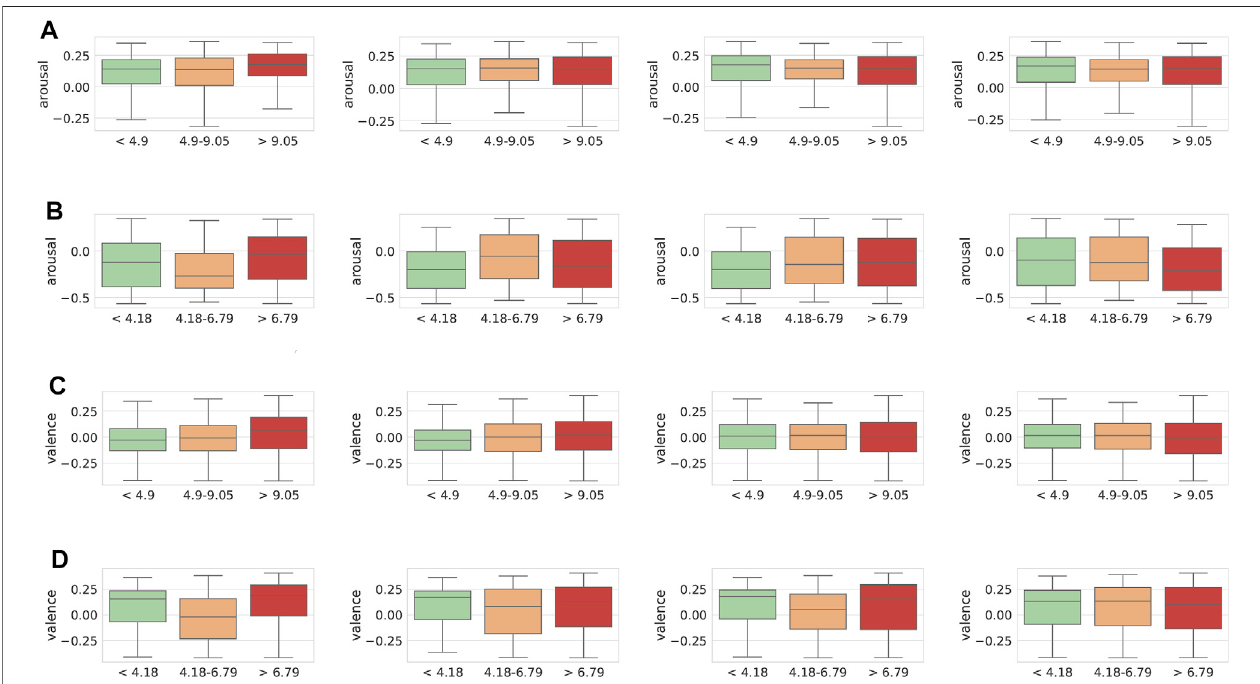
FIGURE10| Boxplotsofpredictedarousalvalencevaluesforthe FAU-TSST and REG-TSST .Groupedbasedonrawcortisol(nmol/L)measurestakenattimepointsS2-S5 (lefttoright) . (A) ArousalwithcortisolgroupsatS2 – S5for FAU-TSST. (B) Arousalwith cortisolgroupsatS2 – S5forR EG -TSST. (C) Valencewith cortisolgroupsatS2 – S5 for FAU-TSST. (D) Valence with cortisol groups at S2 – S5 for R EG -TSST.